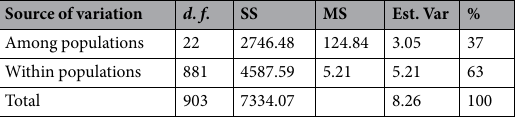
Table 1. Analysis of molecular variance (AMOVA) for 23 population structures of P. clarkii